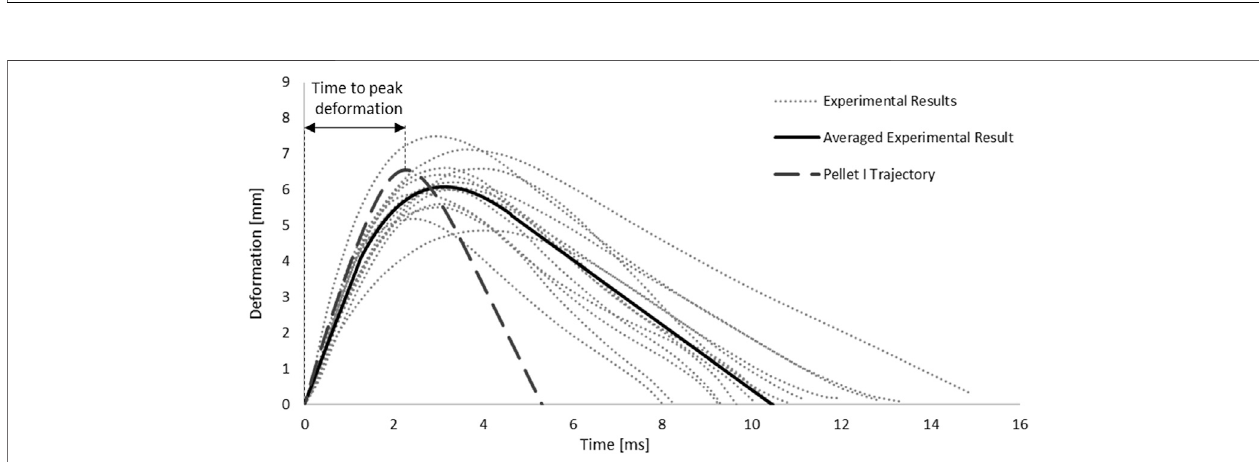
FIGURE 7 | Kinematic response of Pellet I compared to the experimental data (Persson 2009).